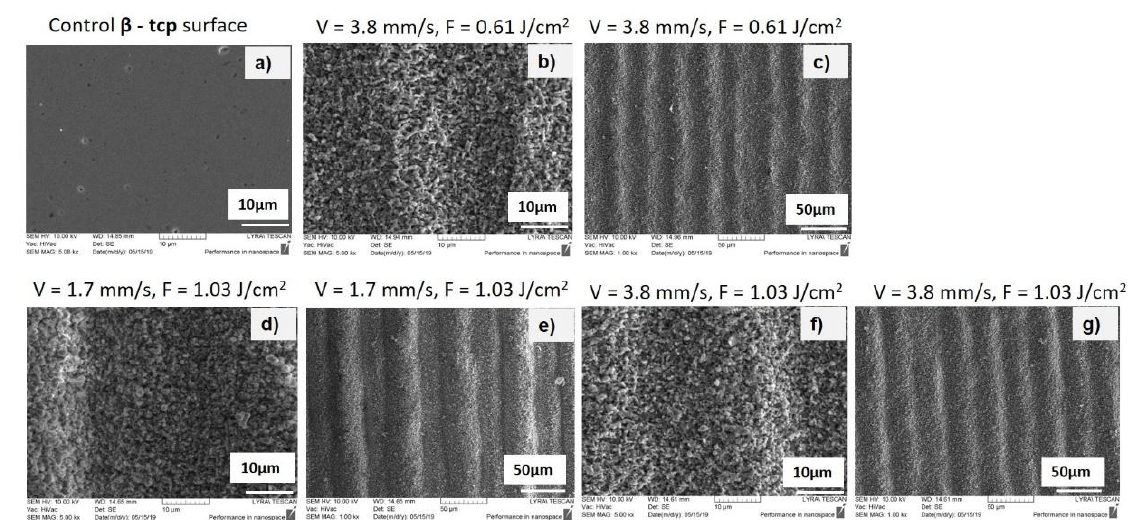
Figure 5. SEM images of surface-modified β -TCP pellets in the form of microchannels formed after laser irradiation in continuous line scan regime with fs-laser pulses for the following: control surface ( a ) and laser modified at F = 0.61 J/cm 2 and V = 3.8 mm/s ( b , c ) and F = 1.03 J/cm 2 , V = 1.7 ( d , e ), and F = 1.03 J/cm 2 , v = 3.8 mm/s; λ = 800 nm; τ = 130 fs ( f , g ).